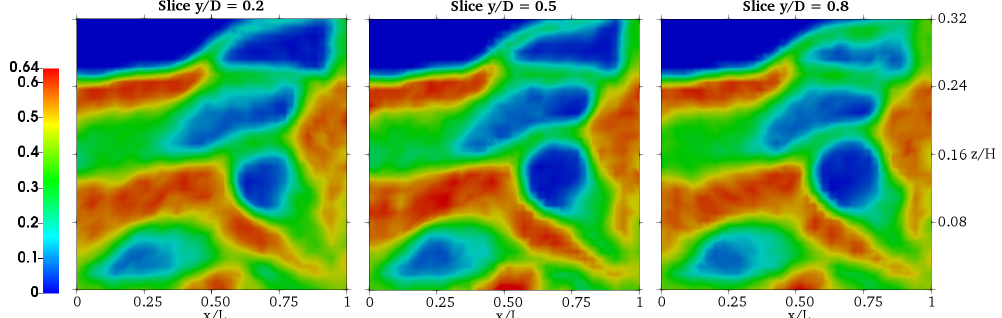
Figure 10. Instantaneous particle volume fraction on different slices of the bed. Simulation C2,